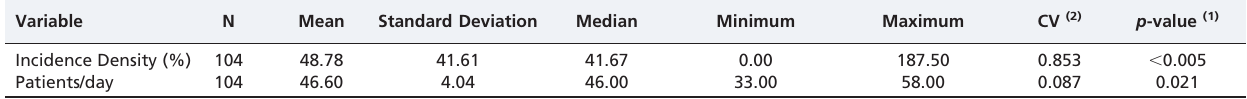
Table 1 - The incidence density rate per 1,000 patients per day and the number of patients per day per epidemiological week. The adult ICU data are for 2004 and 2005.